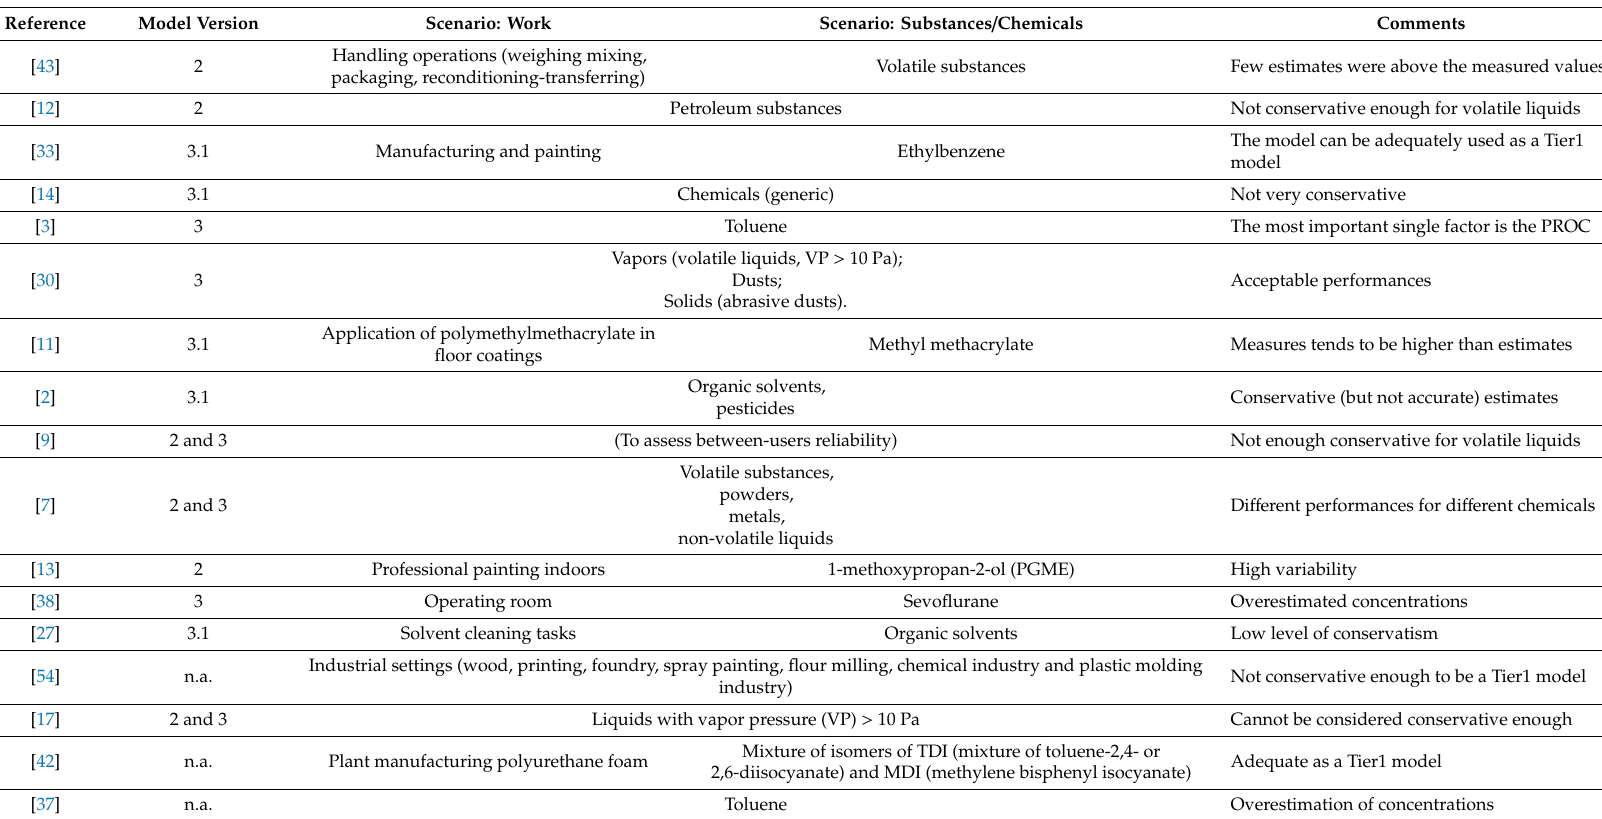
Table 6. Summary of articles concerning the ECETOC TRA model founds in the present